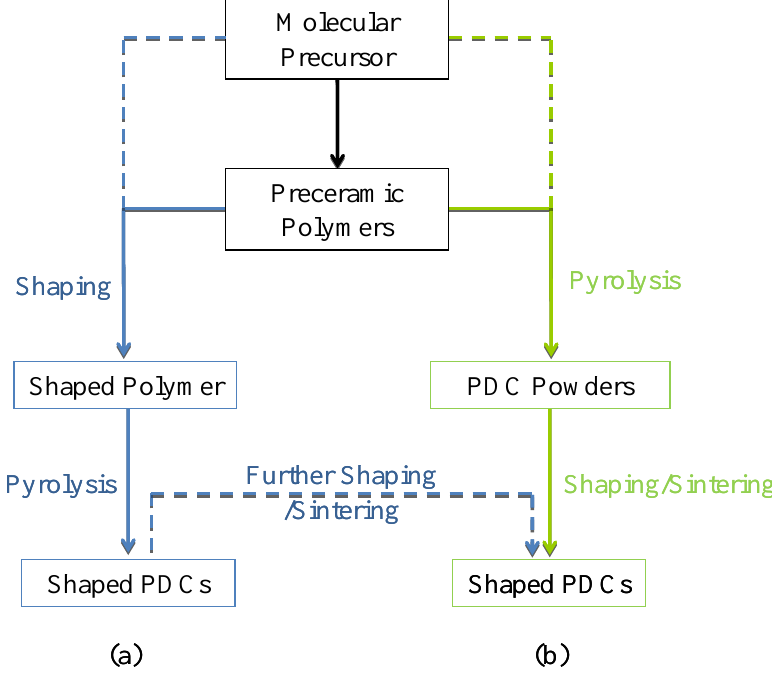
Figure 1. Overall process for preparing Polymer-Derived Ceramics (PDCs): ( a )